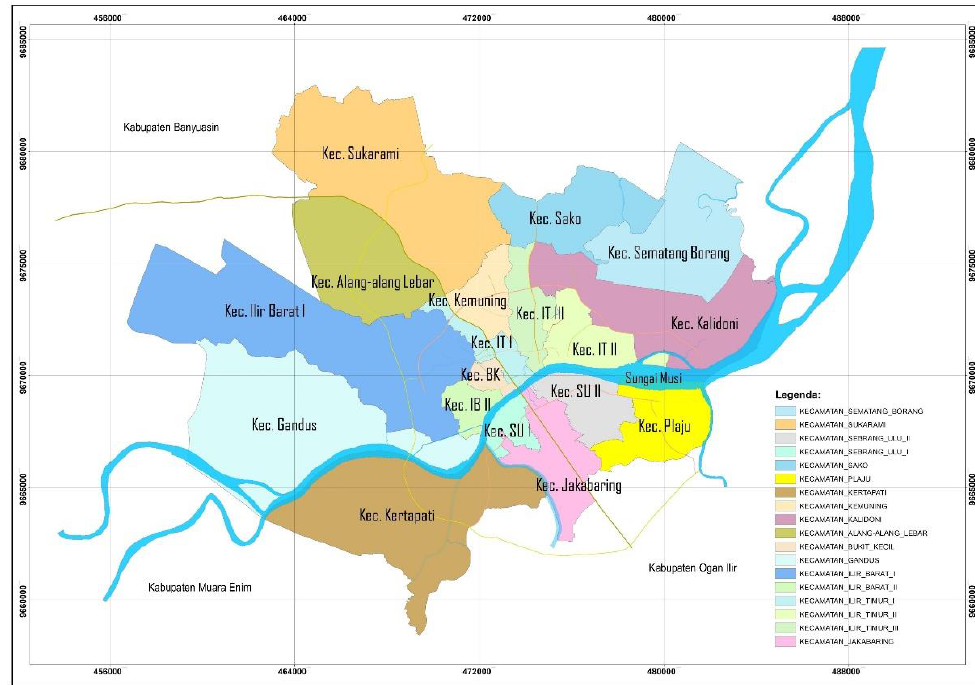
Figure 1. A map of the greater area of Palembang [52].